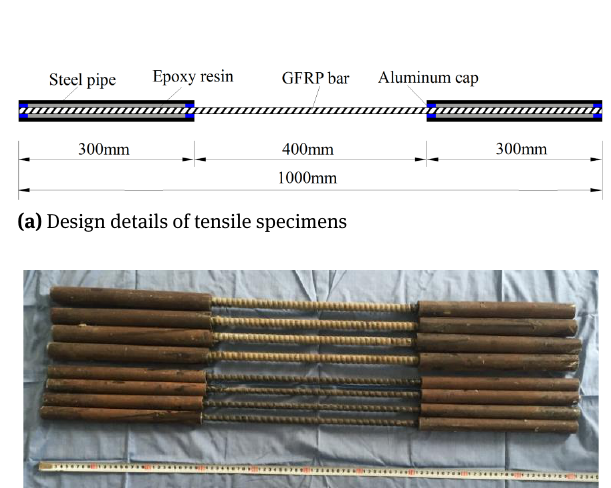
Figure 2: GFRP bars immersed in different solutions